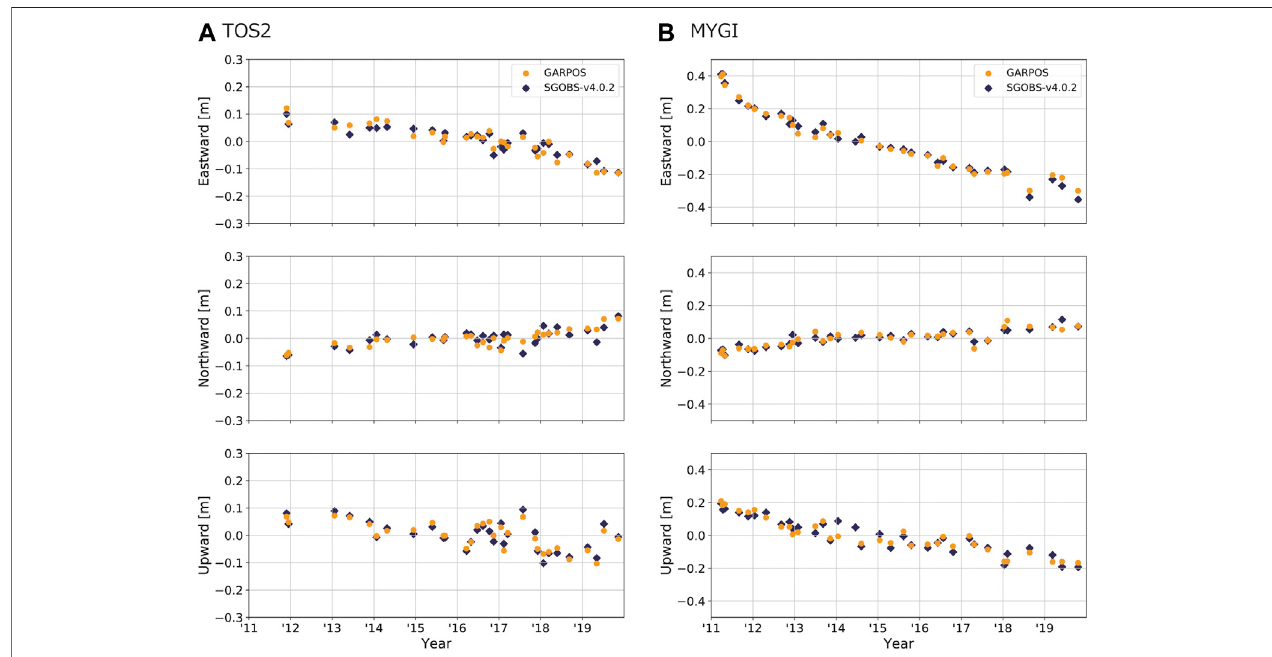
FIGURE6| Timeseriesofdisplacementat (A) TOS2and (B) MYGIsolvedbyGARPOS(orangecircles)andSGOBSversion4.0.2(bluesquares).Thepositionsare aligned to the ITRF 2014.